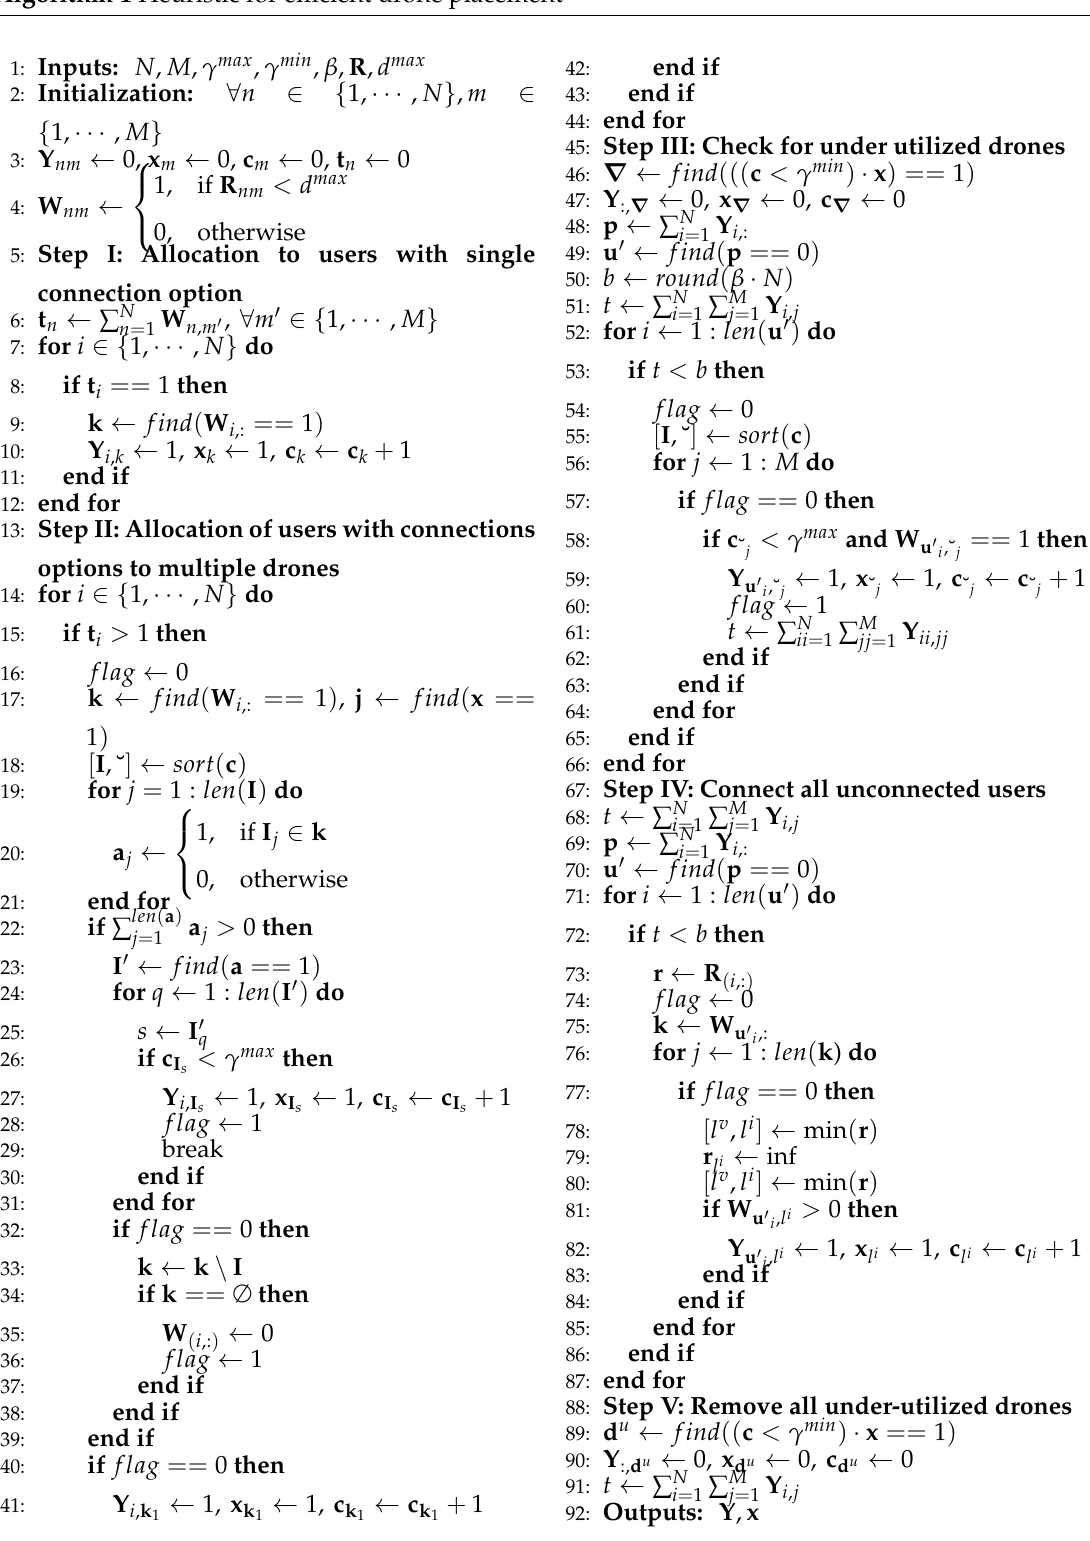
Algorithm 1 Heuristic for efficient drone